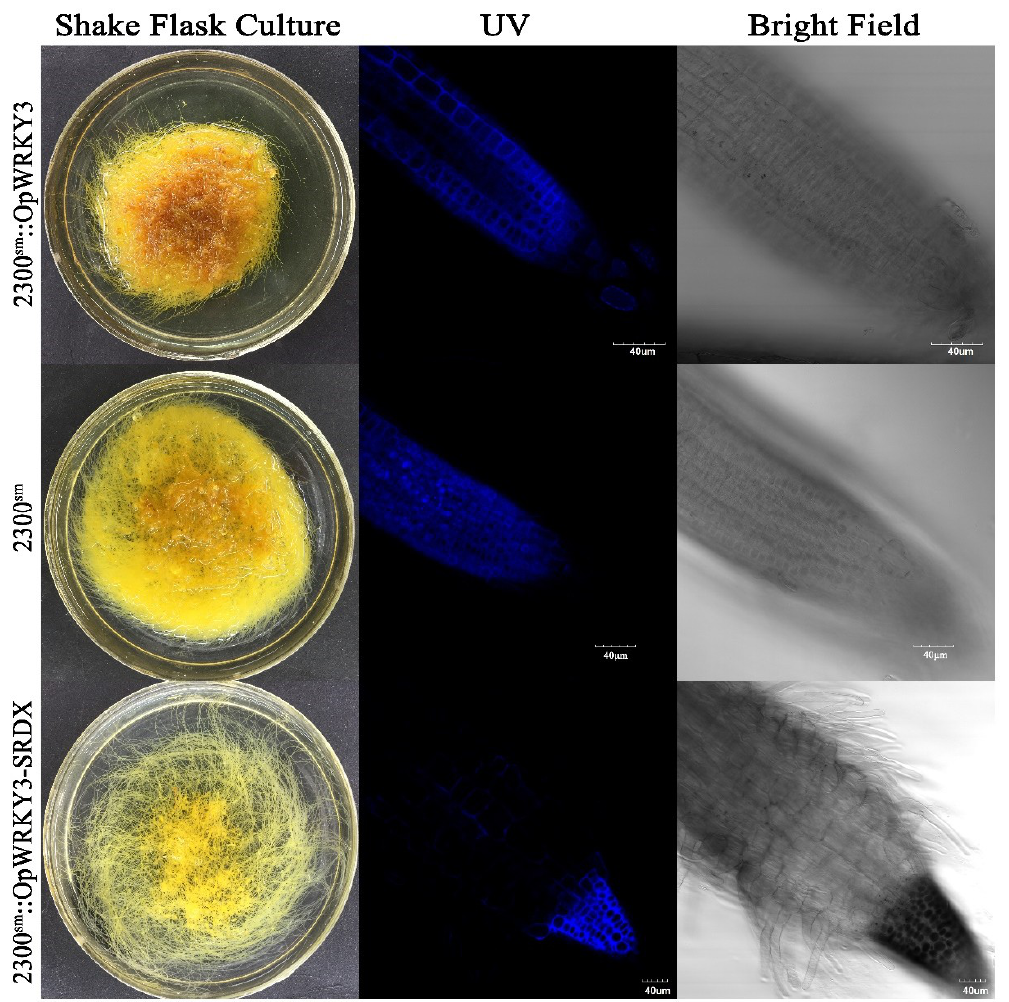
Figure 4. The OpWRKY3 transgenic hairy roots of camptothecin distribution in the root tip.